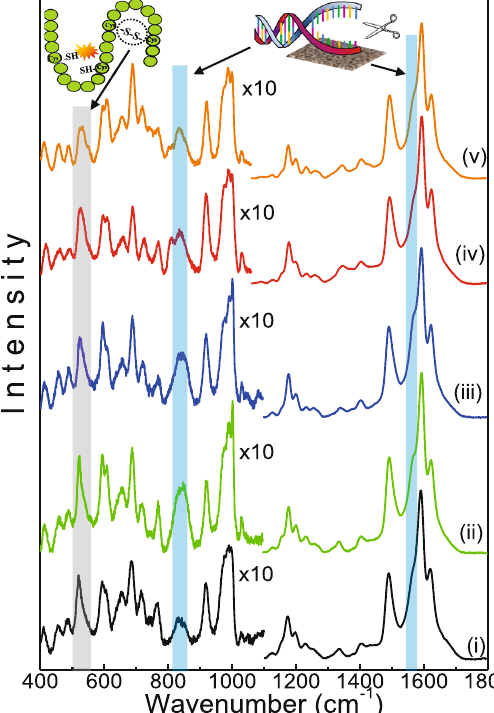
Figure 2. Average SERS spectra of 4T1 breast cancer cells for control group and cells treated with the NE/PS5 and NE/PS10 complexes. Each spectrum represents an average of 30 spectra recorded from cellular samples. In the low energy region (400–1100 cm − 1 ) the band intensities were multiplied by 10. The inserted pictures emphasize the vibrational modes related to the protein disulfide bonds (-S-S-) at ~525 cm − 1 and DNA fragmentation responsible for the SERS intensity variation associated with phosphodiester bonds (~813 cm − 1 ) and guanine/adenine bases (~1565 cm − 1